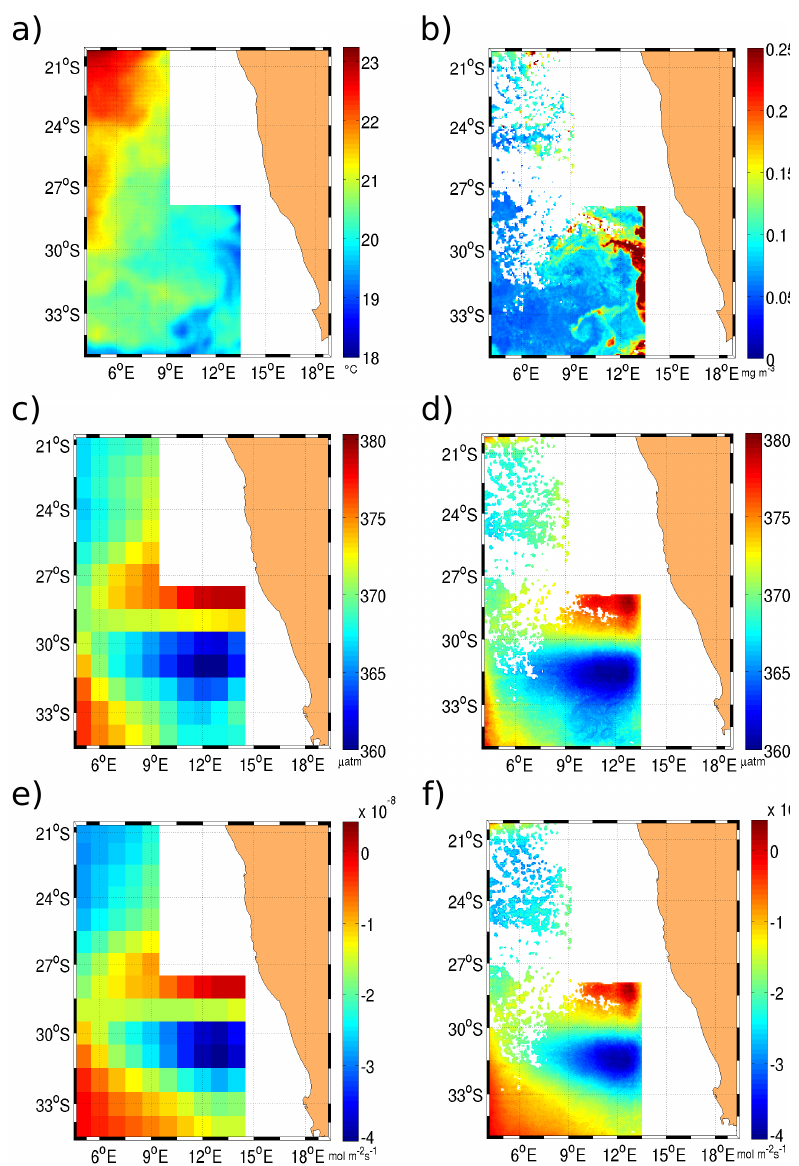
Figure 5. Maps of (a) SST from OSTIA at 1 / 32 ◦ of spatial resolution, (b) Chl a at 1 / 32 ◦ of spatial resolution from GSM GLOBCOLOUR products, (c) ocean p CO 2 from CarbonTracker at the spatial resolution of 1 ◦ , (d) inferred p CO 2 at super resolution (4km, i.e., 1 / 32 ◦ ) derived from OSTIA SST and GLOBCOLOUR-GSM Chl a shown in (a) and (b) , respectively, (e) Air–sea CO 2 flux as derived from CarbonTracker and (f) Air–sea CO 2 flux computed from super-resolution p CO 2 shown in (d) at 1 / 32 ◦ . All images correspond to 22 March 2006. White color corresponds to invalid pixels due to cloudiness and points inside of the CarbonTracker land